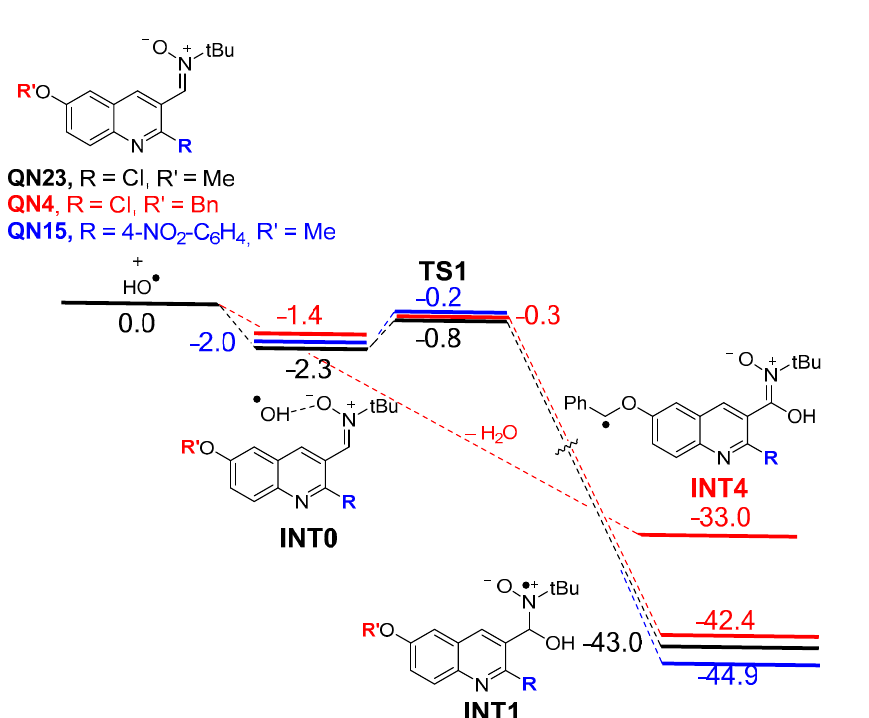
Figure 5. Comparative computed reaction profiles for the reaction of HO • with QN23 (black), QN4 (red) and QN15 (blue) on the electrophilic carbon atom of the nitrone moiety. Relative free energy values ( Δ G, at 298 K) are given in kcal/mol. All data have been computed at the B3LYP-D3/def2-SVP level.